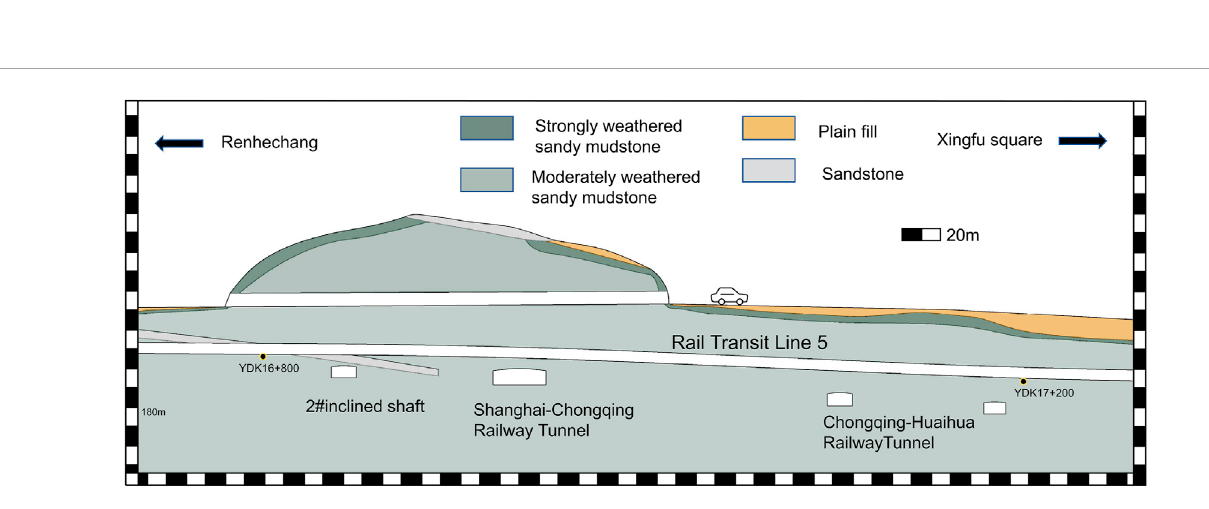
and downward line. The right-line tunnel of the subway intersects with the Chongqing-Huaihua Railway downward tunnel at DK14+803, at a clear distance of 10.743 m, and intersects with the Chongqing- Huaihua Railway upward tunnel at DK14+786, in a clear distance of 10.69 m; the left line tunnel of the subway intersects DK14+831 of Chongqing-Huaihua Railway downward tunnel in a clear distance of 8.946 m, and DK14+758 of Chongqing-Huaihua Railway upward tunnel in a clear distance of 11.944 m. The speci fi c adjacent spatial relationship is shown in Figure 5. The corresponding mileage range of complex adjacent tunnels of Chongqing Metro is shown in Table 2.